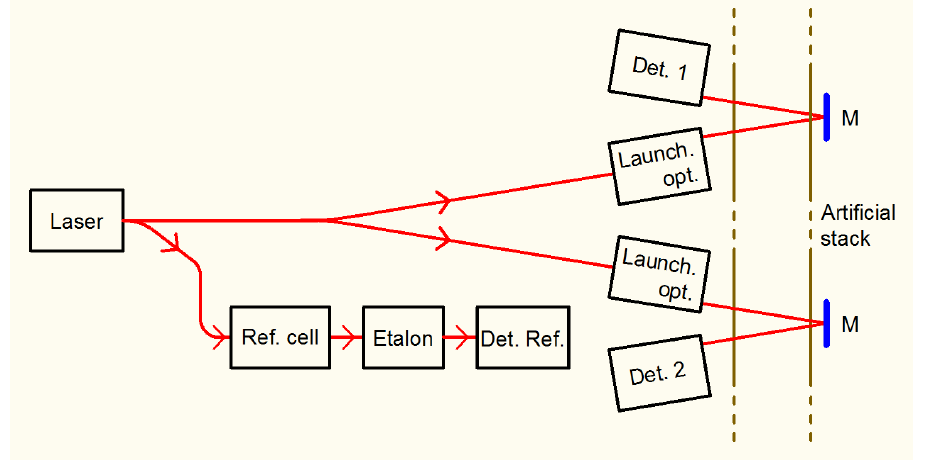
Figure 3. Block diagram of the optics. M: flat Mirror. The angle between the two couples of beams inside the stack is exaggerated for the sake of clarity.